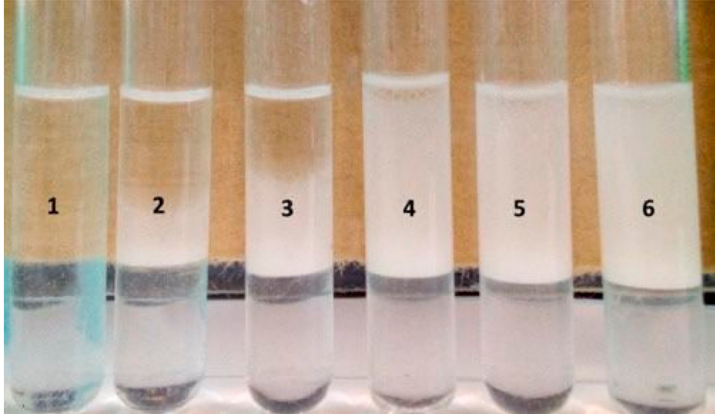
Figure 10. Emulsification assay. Emulsification tests using 1 mL of n-heptane as organic phase and 1 mL of aqueous phase containing increasing amounts of crude BS/BE (0.352 g/L solution)—1: control (0), 2: 100 µL, 3: 200 µL, 4: 325 µL, 5: 350 µL, and 6: 400 µL. Using 350 µ L of this crude 100% emulsion of organic phase is attained. Source: [93].